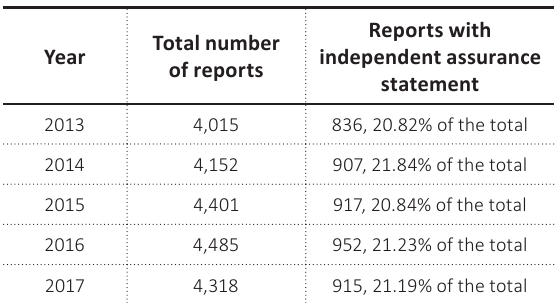
Table 1. Total number of integrated reports